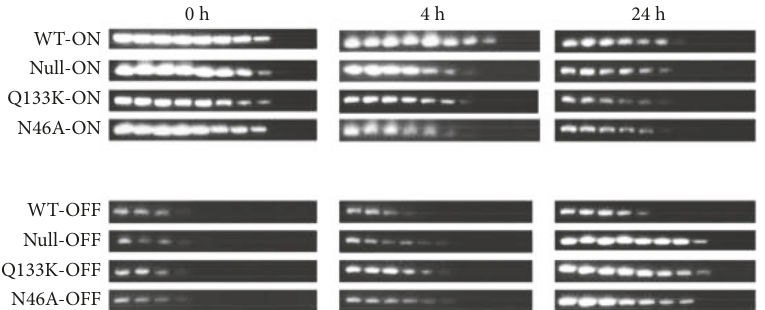
Figure 4: Quantitative determination of the fimS invertible element orientation of E. coli cells with a plasmid that has the FimH protein represented as wild type (WT), Null, Q133K, or N46A mixed with mannose-coated Sepharose beads (+) for 0h, 4h, or 24 h. The PCR analysis was performed with twofold dilutions of chromosomal DNA isolated from the E. coli cells using the INV and FIMA primers to amplify Phase- ON-oriented DNA (450 bp product) or FIME and INV primers to amplify Phase-OFF-oriented DNA (750bp product). All PCR products were electrophoresed on 1.5% agarose gels. The following dilutions of DNA were used: undiluted (lane 1), 1/2 (lane 2), 1/4 (lane 3), 1/8 (lane